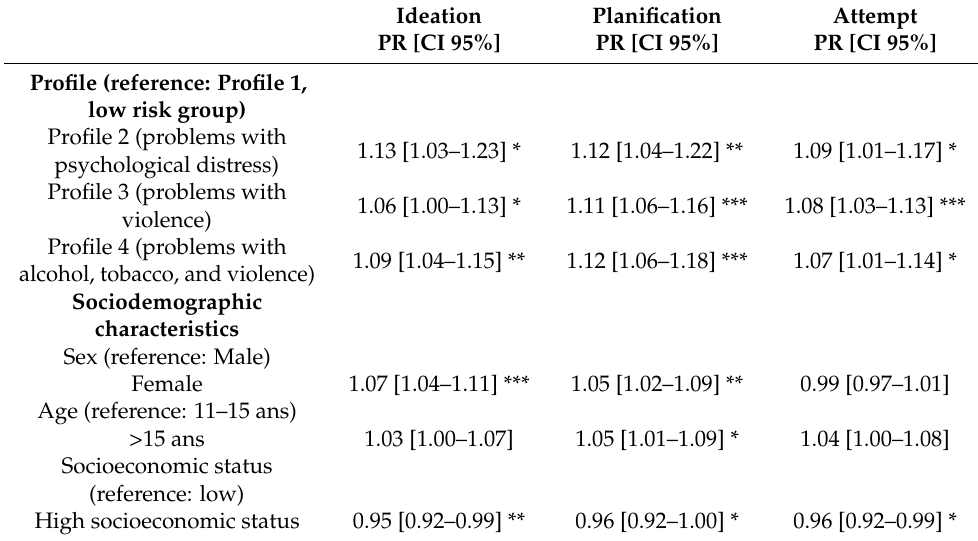
Table 6. Association between suicidality and profiles among adolescents aged 11 to 18 in Benin,